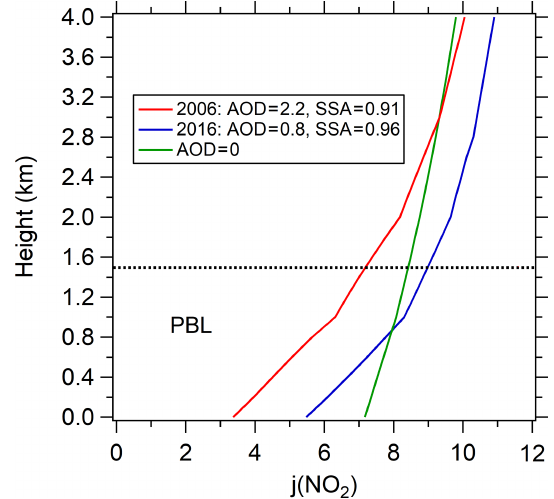
Figure 12. Vertical profiles of J( NO 2 ) simulated by the TUV model in Beijing. Three scenarios are simulated: the model parame- ters are (1) AOD = 2 . 2 and SSA = 0 . 91 in August 2006, (2) AOD = 0 . 8 and SSA = 0 . 96 in August 2016, and (3) AOD = 0. The daytime average SZA = 53 ◦ is used for all simulations. The dotted line rep- resents the top of the boundary